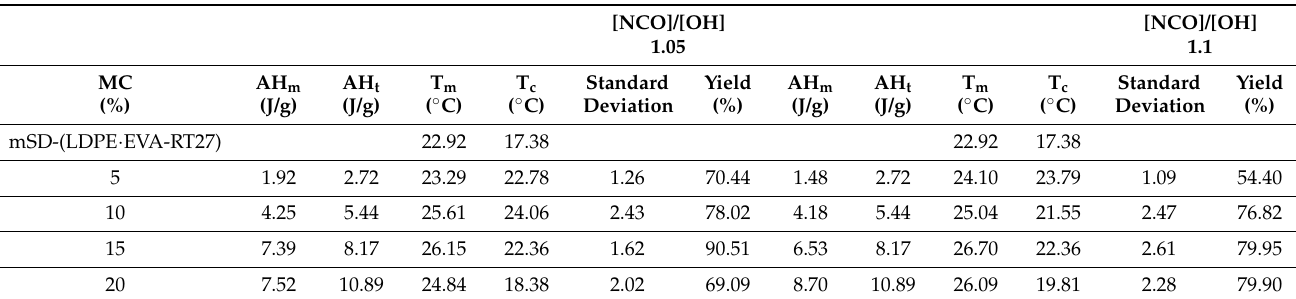
Table 3. Average latent heat ( ∆ H m ), theoretical latent heat ( ∆ H t ), standard deviation, melting temperature (T m ), crystal- lization temperature (T c ) and yield of the elastomers with different mSD-(LDPE · EVA-RT27) contents and [NCO]/[OH] molar